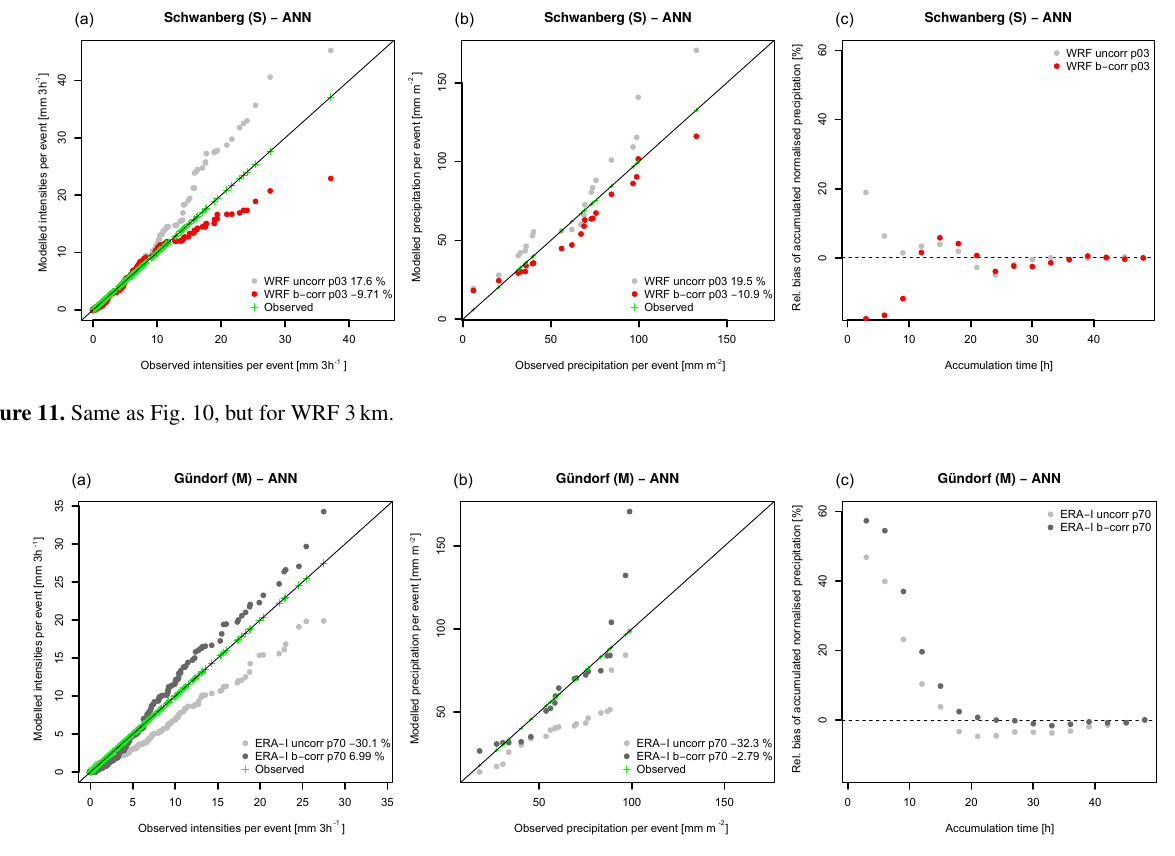
Figure 12. Same as Fig. 10, but for ERA-Interim in the Gündorf catchment.